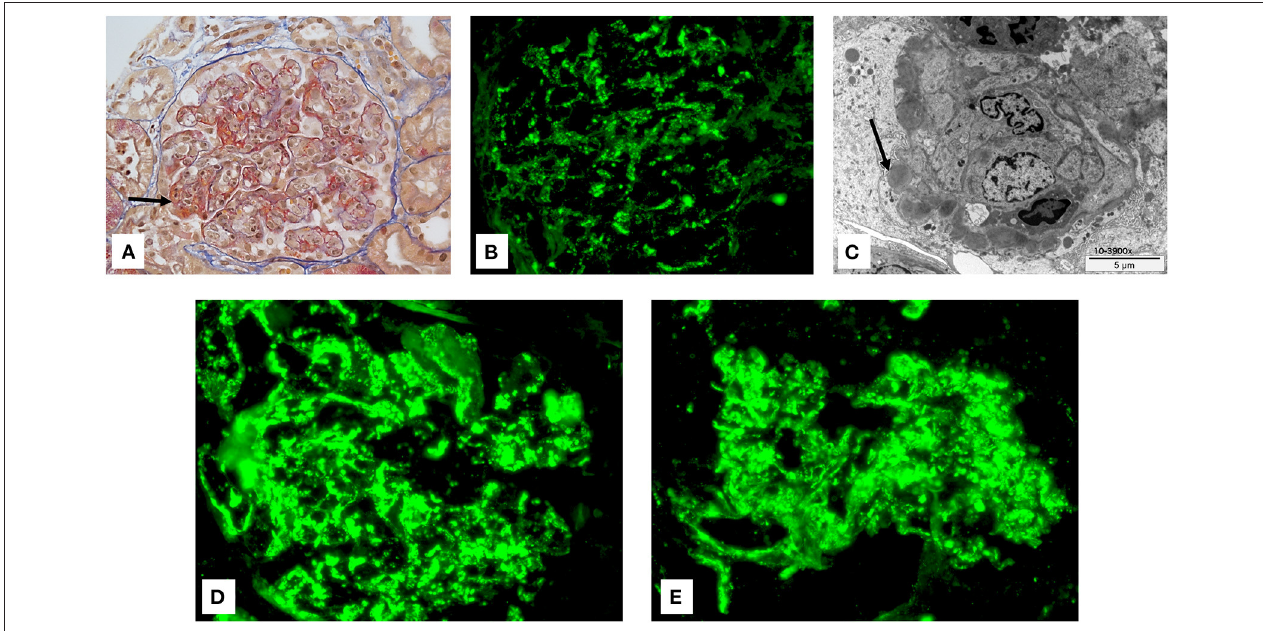
FIGURE 1 | (A) Glomeruli show a lobular flocculus with a global and diffuse endocapillary proliferation associated with mesangial hypercellularity. Crescents with fibrinoid necrosis were present (arrow) (Trichrome stain: original magnification: 400 × ). (B) By immunofluorescence, IgG deposits were diffusely observed and organized in a starry sky pattern (FITC: original magnification: 400 × ). (C) Numerous subepithelial (humps) and mesangial dense deposits were observed by electronic microscopy. Arrow shows so called humps. (D,E) By immunofluorescence, C3 (D) and C5-9 (E) deposits were diffusely observed (FITC: original magnification: 400 ×